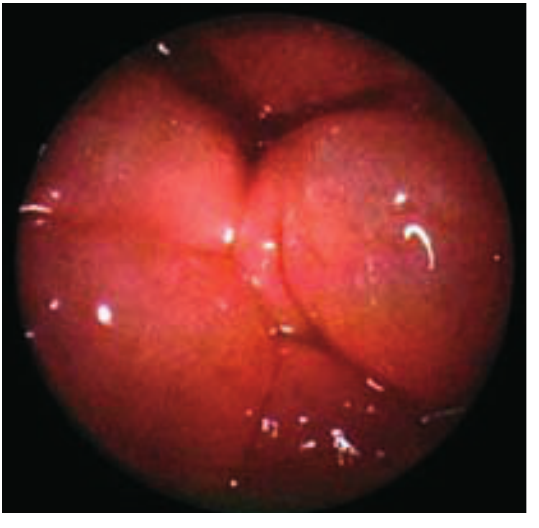
Figure 2 Infected epiglottis = epiglottitis.